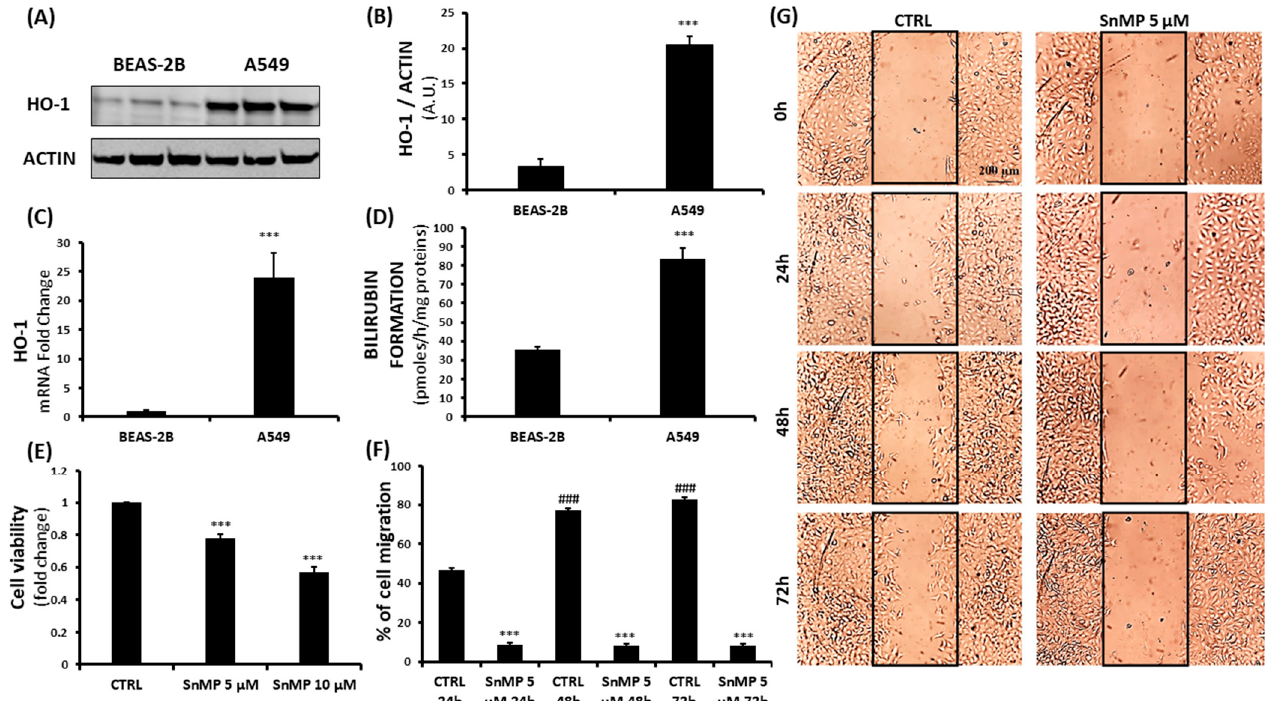
Figure 1. ( A – D ) Evaluation of HO-1 basal levels in healthy human bronchial epithelial (BEAS-2B) and human lung adenocarcinoma (A549) cell lines, investigating differences in protein content, gene expression and enzymatic activity (*** p < 0.001 vs. BEAS-2B). ( E ) Assessment of SnMP (5 µ M, 10 µ M) effect on A549 cell viability (*** p < 0.001 vs. CTRL). ( F , G ) SnMP effect on A549 cell migration rate. ( ### p < 0.001 vs. CTRL 24 h, *** p < 0.001 vs. CTRL 24 h, 48 h and 72 h). Results are expressed as mean ± SEM.